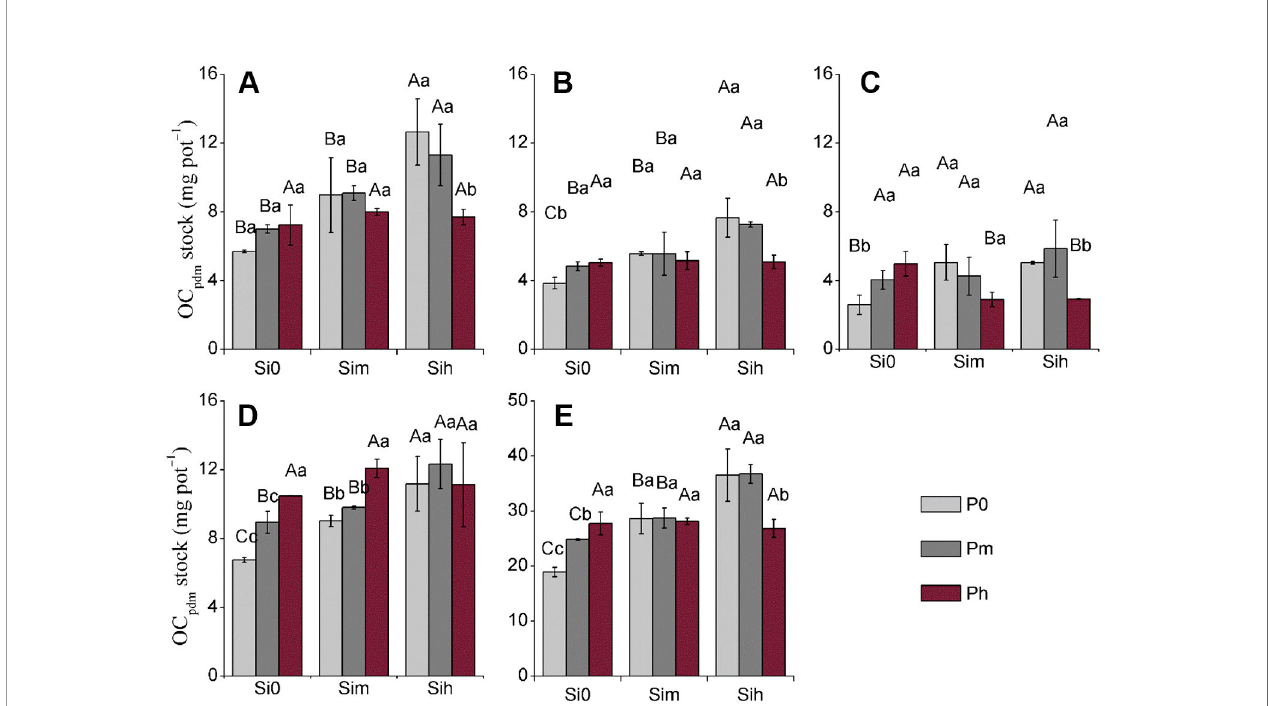
FIGURE 3 | Stock of OC pdm (mg pot − 1 ) at two-way analysis of variance of silicon-phosphorus (Si-P) levels in the different plant parts. (A) Leaf; (B) fl ag leaf; (C) : stem; (D) : sheath; (E) rich shoot. Error bars represent the standard deviations of the means. Different lowercase letters indicate signi fi cant differences among the treatments in different P treatments and rice plant parts at a given Si level, respectively [least signi fi cant difference (LSD) test; p < 0.05]. Different uppercase letters indicate signi fi cant differences among the treatments in different Si treatments and rice plant parts at a given P level, respectively (LSD test; p < 0.05, n =